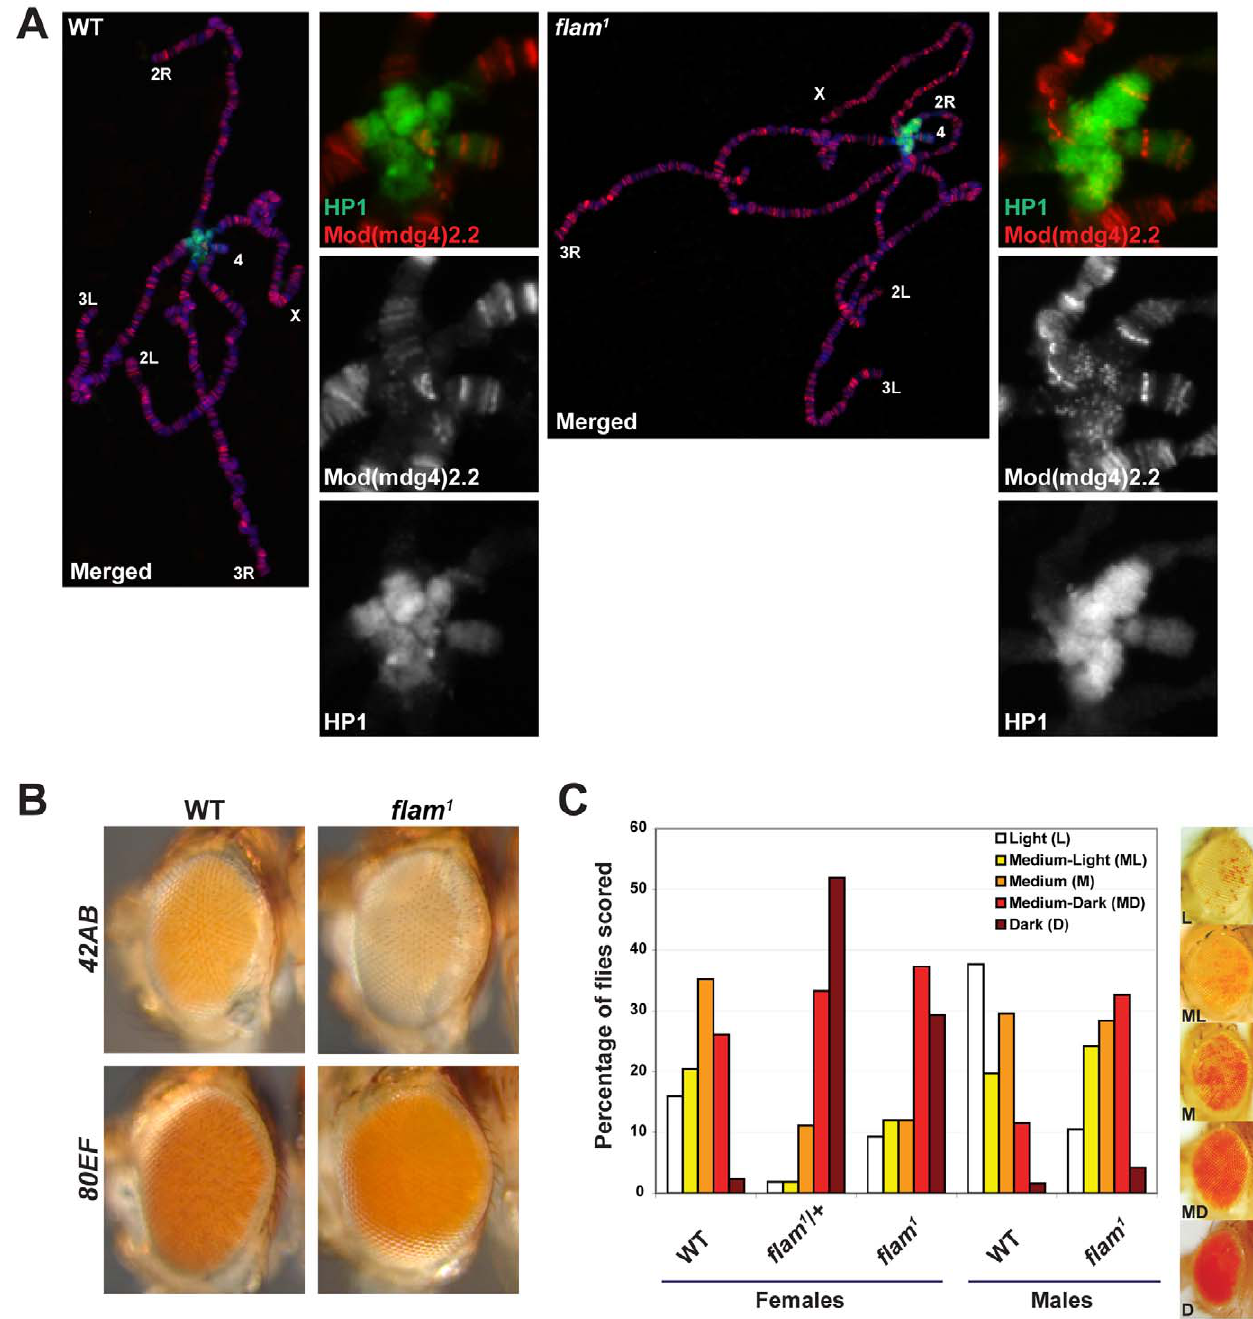
Figure 6. Mutation of the flam piRNA cluster results in global HP1 redistribution. (A) Wild type (left) and flam 1 (right) polytene chromosomes stained with antibodies directed against HP1 (green) and a reference protein Mod(mdg4)2.2 (red). DNA is stained with DAPI (blue). Chromosome arms are labeled, and insets of the enlarged chromocenter are shown. (B) Adult eyes of wild type and flam 1 mutants carrying a mini- white transgene inserted in 42AB (top row) and 80EF (bottom) piRNA clusters. (C) Degree of eye pigmentation due to expression of the DX1 transgene array at 50C on chromosome 2L, which undergoes repeat-induced heterochromatic silencing, in wild type, flam 1 / + , and flam 1 female flies and wild type and flam 1 male flies. Scoring of variegation in the eye is categorized into five groups that range between light (few pigmented facets) to dark (almost all pigmented facets). Percentage of flies falling into each category was graphed. Representative eyes are shown on right. doi:10.1371/journal.pgen.1000880.g006 phenotype similar to PEV that is dependent on HP1. Expression of groups that ranged between Light (few pigmented facets) to Dark the DX1 array was assessed based on variegation of eye (almost all facets pigmented). For females, 3% of wild type was pigmentation in wild type, heterozygous flam 1 / + , and homozygous classified as Dark, while 29% of flam 1 / + and 52% of flam 1 mutants or hemizygous flam 1 mutants (Figure 6C). Due to a wide range of displayed the same high level of pigmentation. In males, 15% of eye coloration, variegation was scored by categorization into five wild type was scored as Medium-Dark or Dark while 40% of flam 1